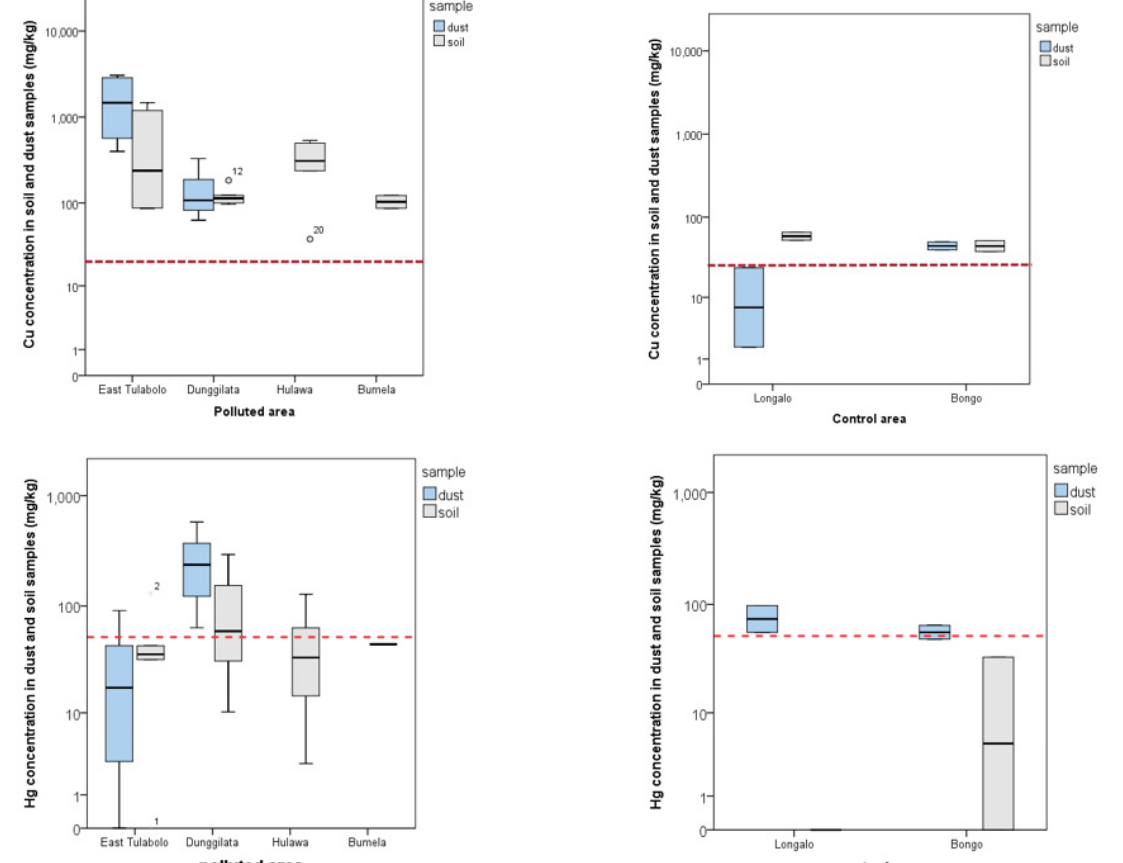
Figure 1. Distribution of copper (Cu) and mercury (Hg) concentrations per area based on polluted and control areas. The mean concentration value uses a logarithmic scale as there is a large difference in the lowest and highest values. The red dotted line indicates the threshold limit according to the regulation. The confidence interval of this study is 95%.